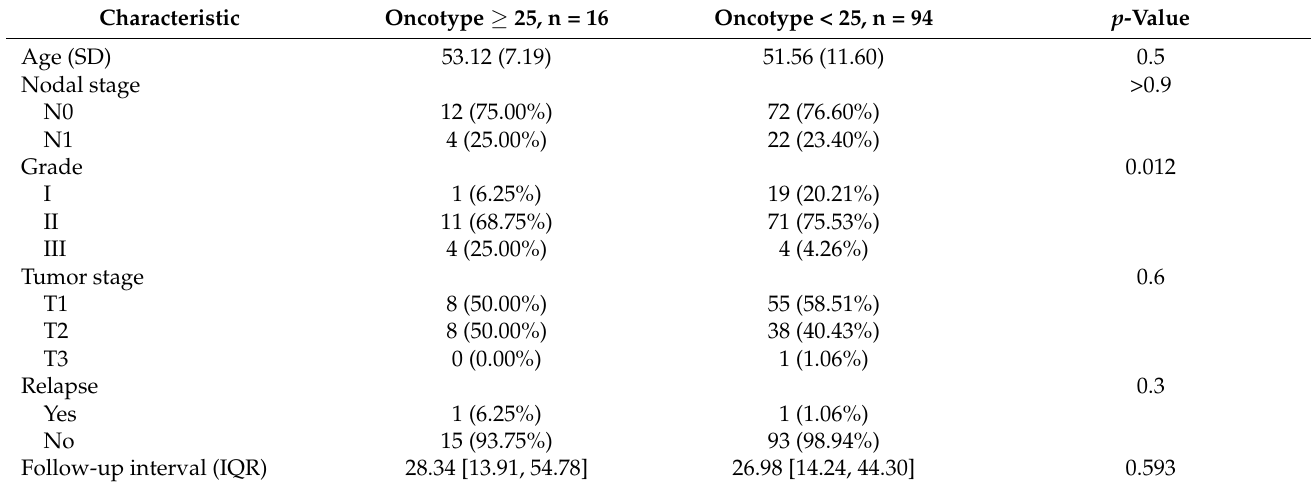
Table 3. Patient characteristics according to the Oncotype DX ®